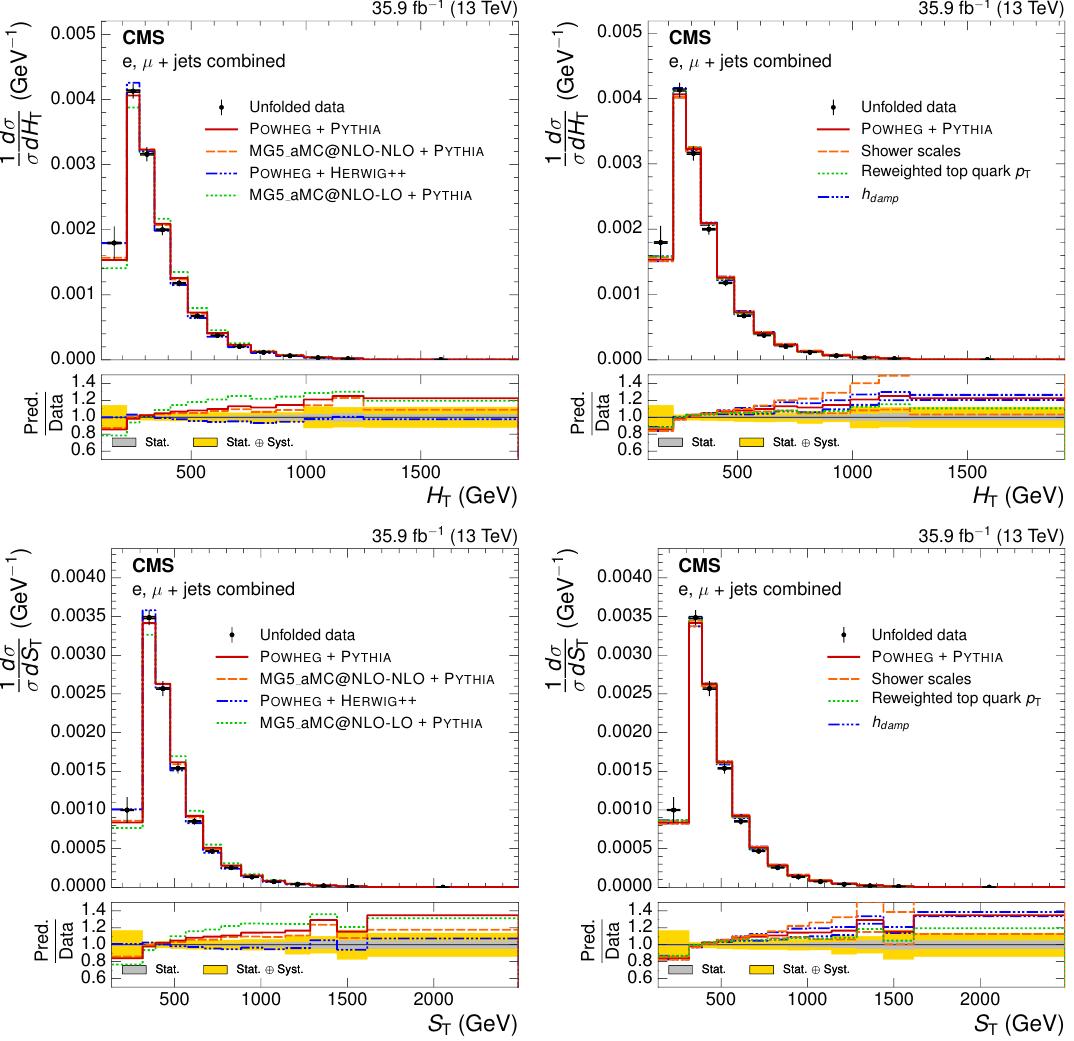
Figure 4 . Normalized H T (upper) and S T (lower) di(cid:11)erential tt cross sections, compared to di(cid:11)erent tt simulations in the left plots, and compared to the powheg + pythia simulation after varying the shower scales, and h damp parameter, within their uncertainties, in the right plots. The vertical bars on the data represent the statistical and systematic uncertainties added in quadrature. The bottom panels show the ratio of the predictions to the